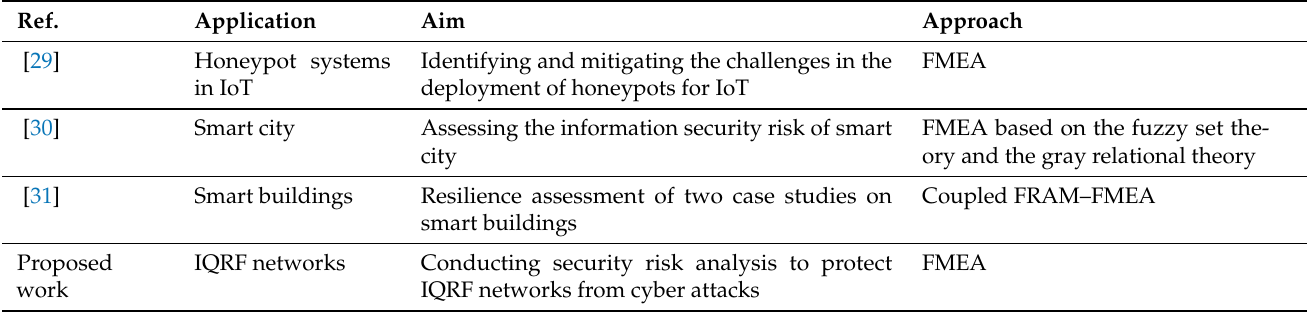
Table 1. Summary of relevant researches on the application of FMEA to IoT-based systems.